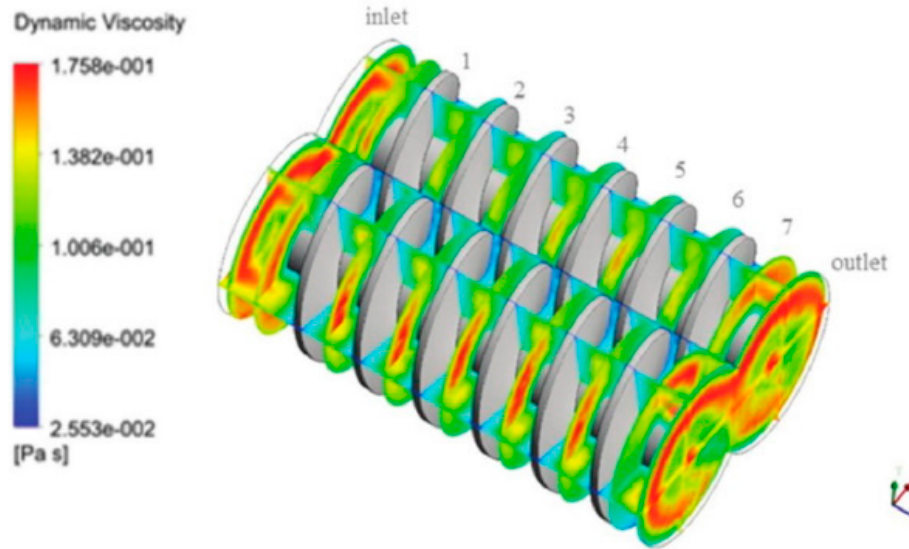
Figure 1. Computational fluid model viscosity contour of twin-screw extruder’s feeding zone with